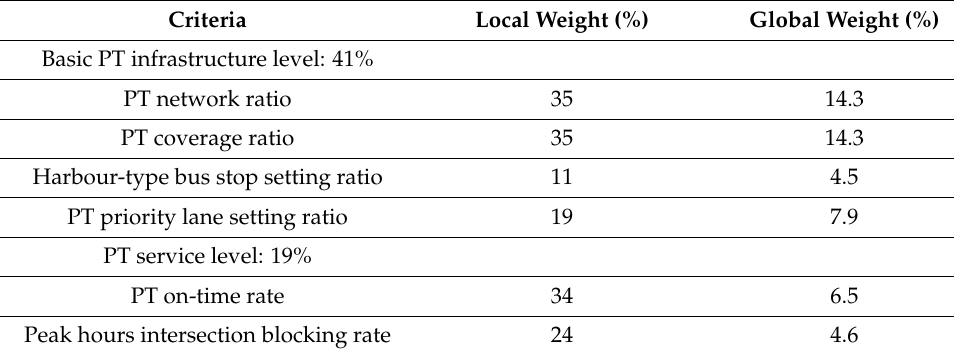
Table A1. The distribution matrix of city score